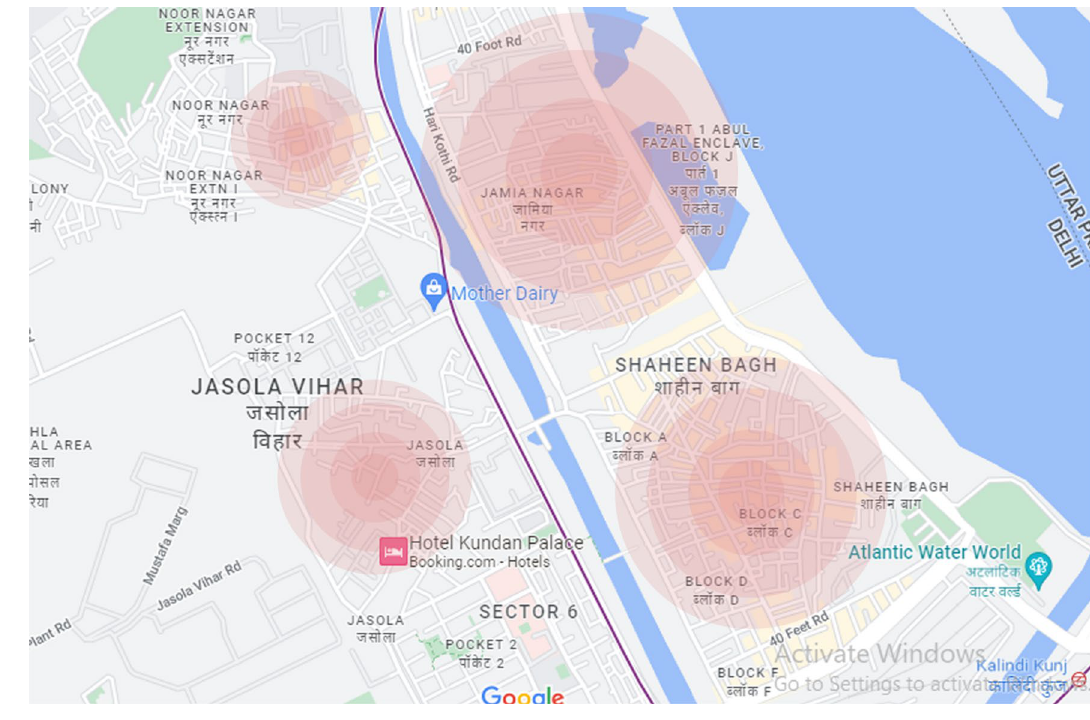
Fig. 4 Mohalla Clinics study zones